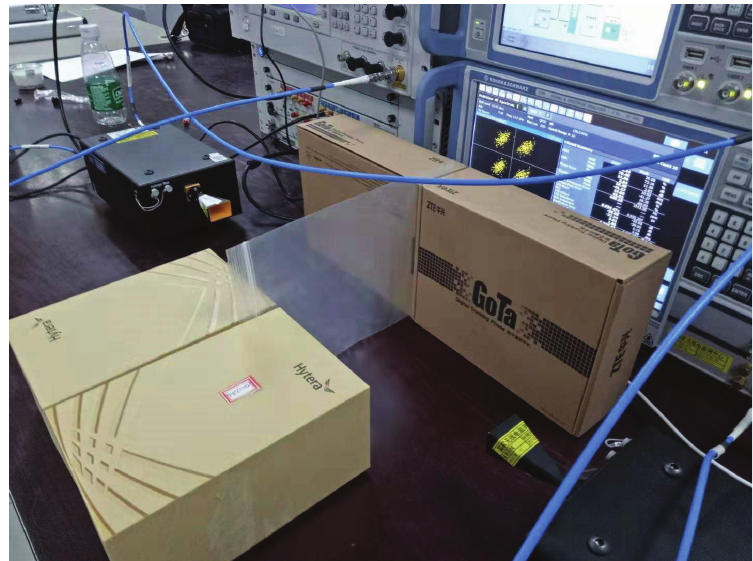
Figure 7. Indoor channel sounding scene 3.